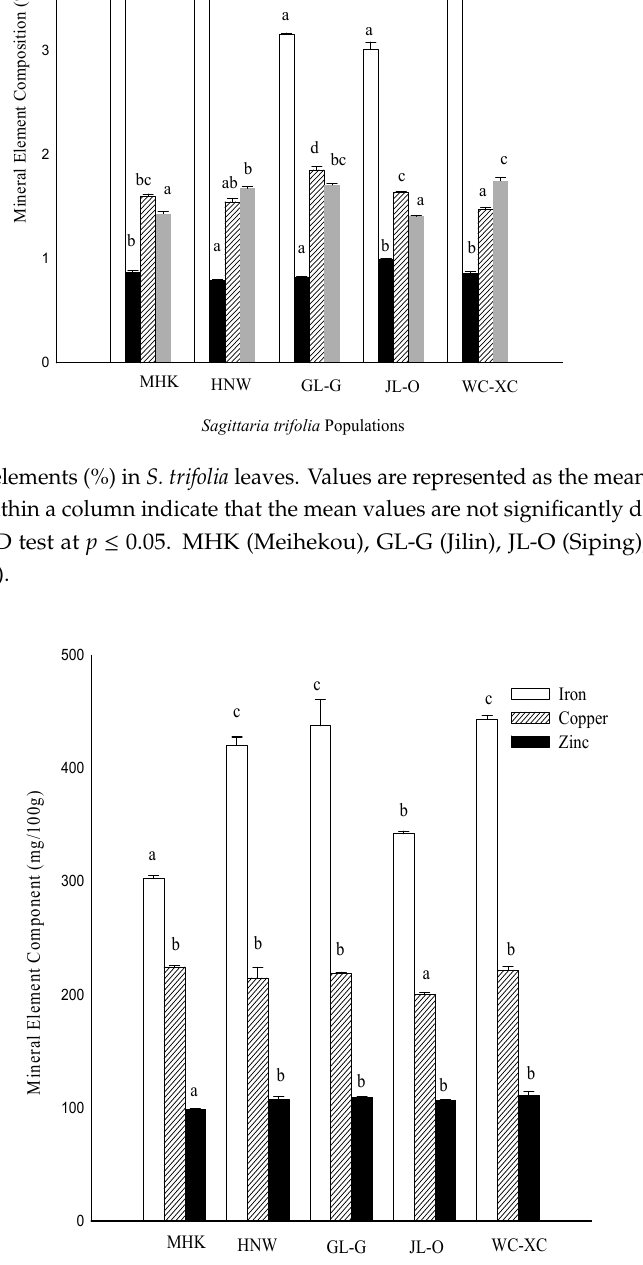
Figure 4. Mineral element (mg / 100 g) in S. trifolia leaves. Values are represented as the mean ± standard error. The same letters within column indicates that the mean values are not significantly different according to the Tukey’s HSD test at p ≤ 0.05. MHK (Meihekou), GL-G (Jilin), JL-O (Siping), HNW (Harbin), WC-XC (Wuchang).